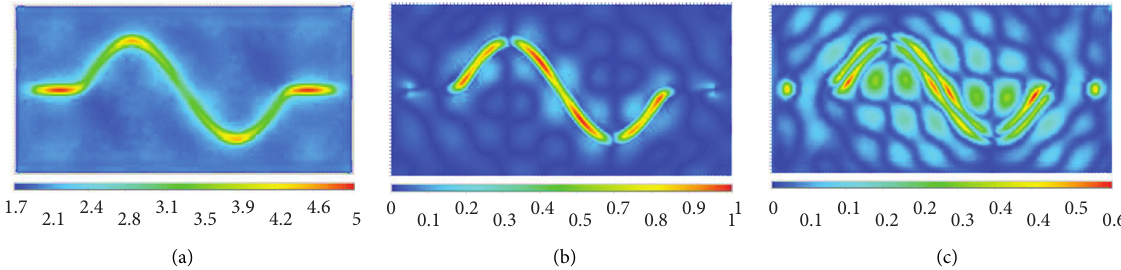
Figure 45: SV wave incident ( C